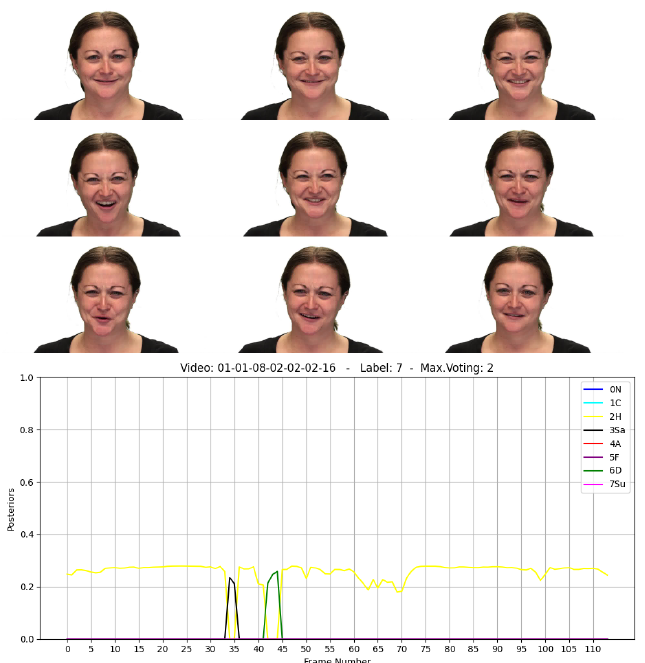
Figure A2. Example of frames from a video tagged as ‘Surprised’ incorrectly predicted as ‘Happy’. The whole video was incorrectly predicted as